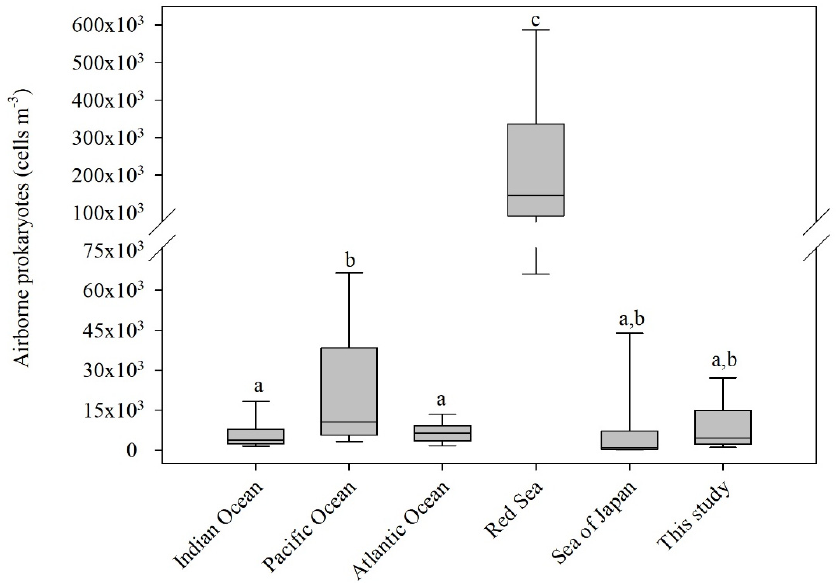
Figure 4. Compilation of airborne prokaryotes abundance over the oceans. Data was compiled from References [12,32–34] and this study. Box-Whisker plots show the interquartile range (25th–75th percentile) of the data set. The horizontal line within the box represents the median value. The letters above the box-plots represent significant differences (ANOVA, p < 0.05) for mean values between sampling sites.